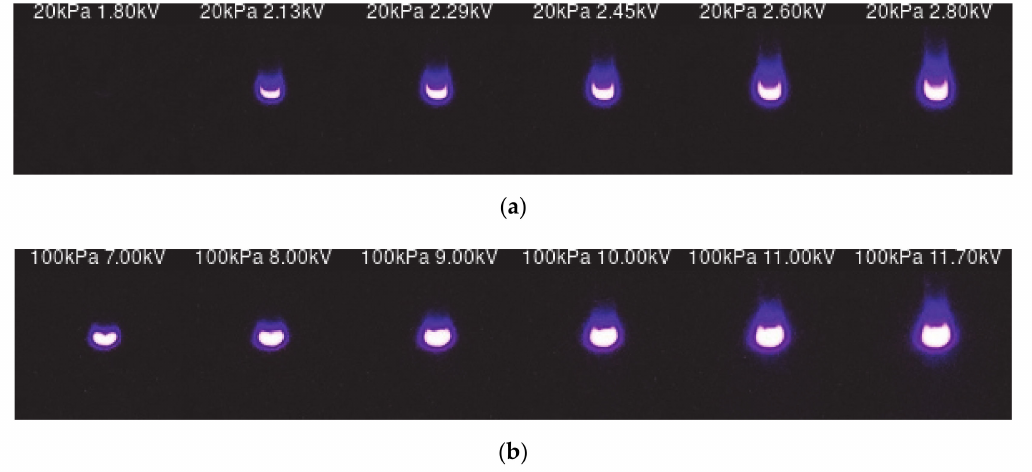
Figure 4. Positive DC corona images taken at di ff erent conditions. ( a ) At 20 kPa applying from left to right 1.8 kV, 2.13 kV, 2.29 kV, 2.45 kV, 2.60 kV and 2.80 kV. ( b ) At 100 kPa applying from left to right 7.0 kV, 8.0 kV, 9.0 kV, 10.0 kV, 11.0 kV and 11.7